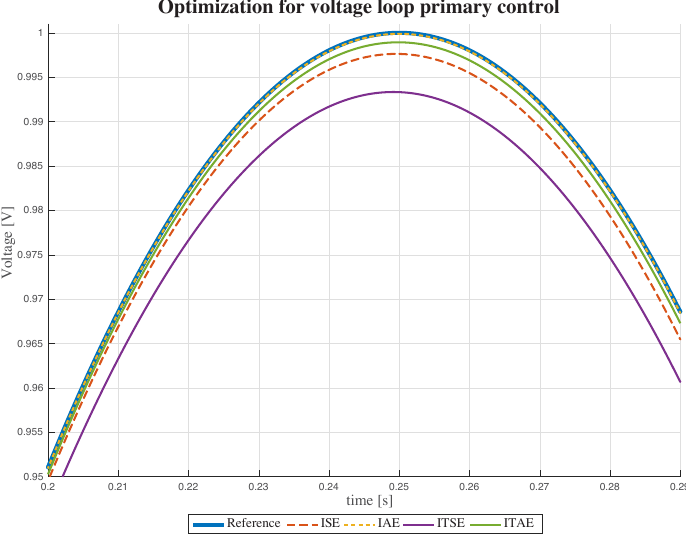
Figure 11. Optimization techniques for voltage inner loop primary control are compared.